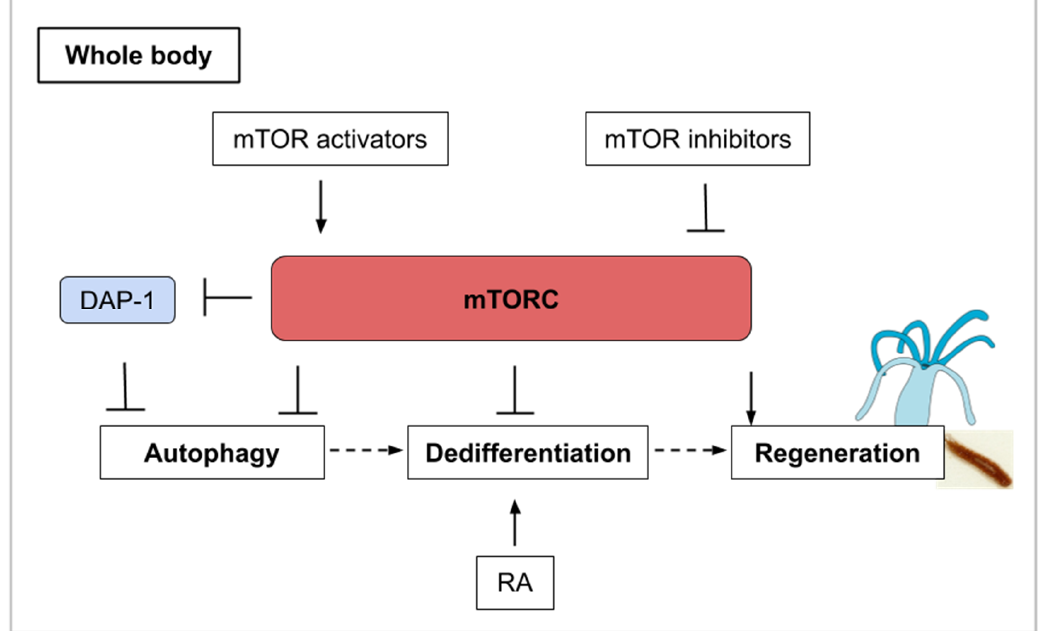
Figure 6. Whole-body regeneration (as explained for cnidarians and planarians) involves different phases of mTORC activity. mTORC inhibition and its induced autophagy are associated with a large increase in cellular ATP which could contribute to stem cell activation. Autophagy is also involved in the process of transdifferentiation, often preceded by dedifferentiation. In combination with mTORC1 inhibition, retinoic acid stimulation induces transdifferentiation. DAP-1 (Death-associated protein 1) inhibits autophagy in conditions of nutrient deprivation. Finally, mTORC activity is upregulated for the regrowth of the missing